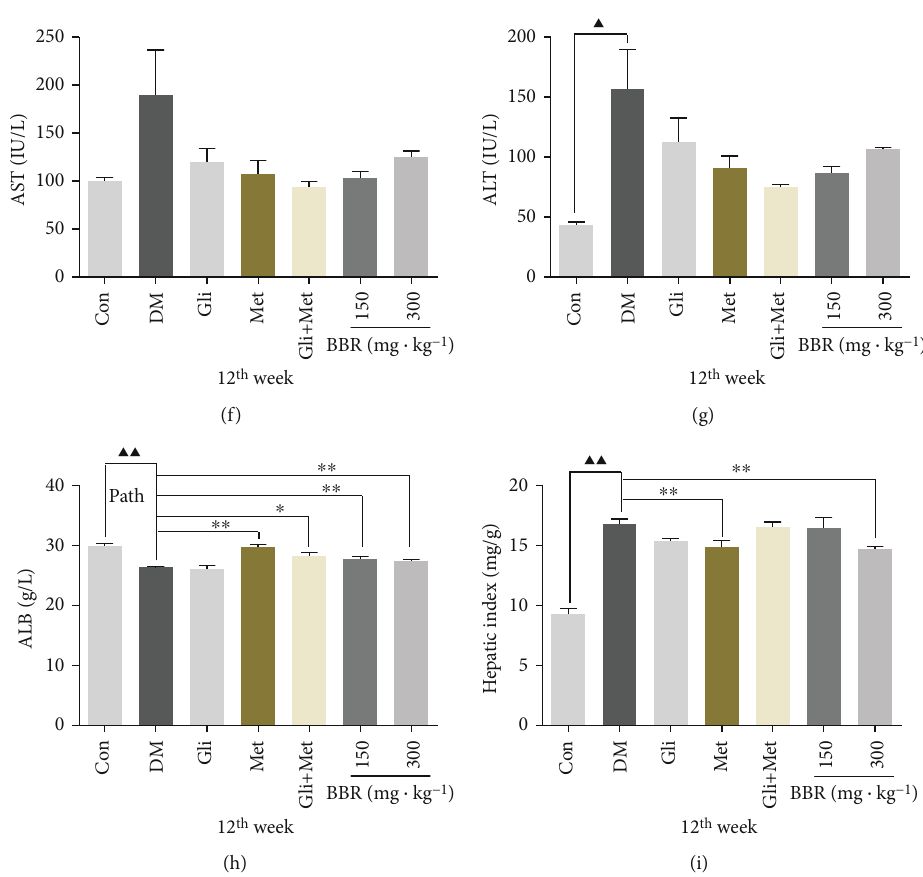
Figure 1: Berberine ameliorates metabolic disorders in ZDF rats. (a) Body weight, food intake, water intake, and urine volume. (b) Fasting blood glucose. Serum levels of (c) BUN, (d) CHOL, (e) LDL-C, (f) AST, (g) ALT, (h) ALB, and (i) hepatic index were evaluated in control rats and ZDF rats with or without glimepiride, metformin, their combination, and BBR treatment. Data are presented as mean ± standard error ( n = 6 rats for each group). ▲ P < 0 : 05 and ▲▲ P < 0 : 01 , Con vs. DM; ∗ P < 0 : 05 and ∗∗ P < 0 : 01 , DM vs. experimental groups. BUN: blood urea nitrogen; CHOL: cholesterol; LDL-C: low-density lipoprotein cholesterol; AST: aspartate aminotransferase; ALT: alanine aminotransferase; ALB: albumin; GLU: